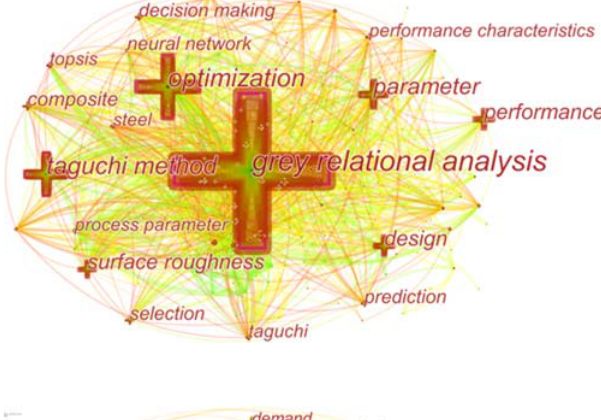
Table V. Top 10 Institutions on the grey system study